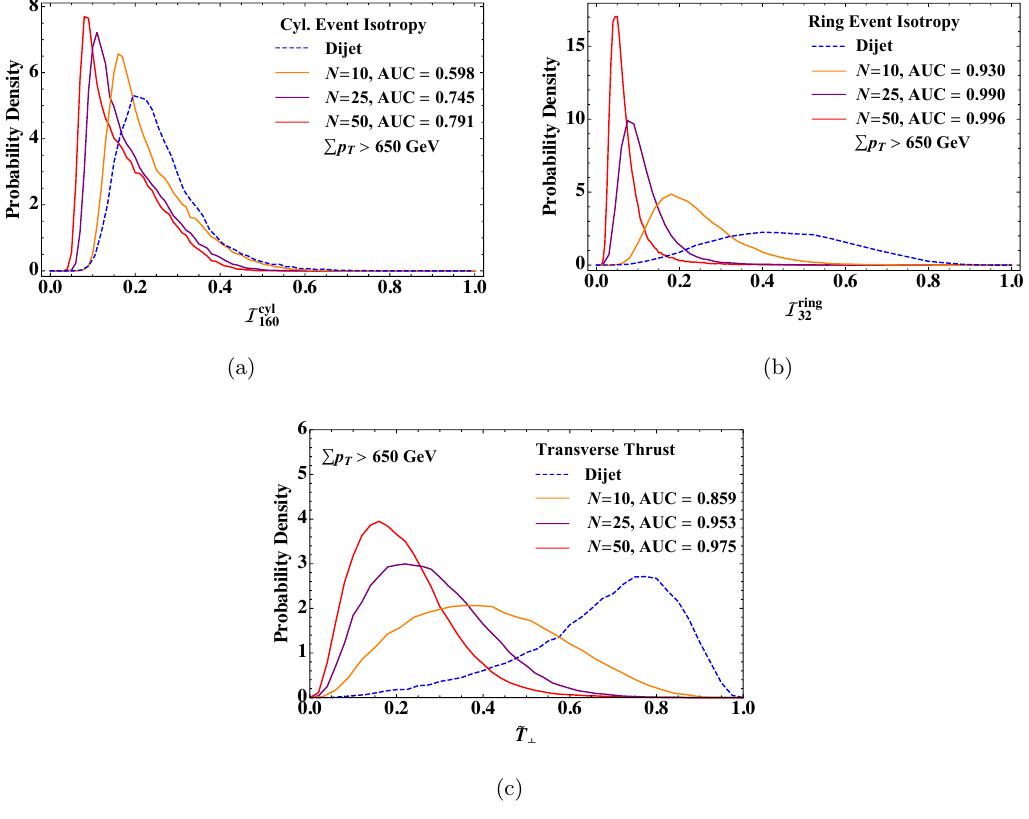
Figure 15 . Comparing the QCD dijet background to uniform N -body samples with N = f 10 ; 25 ; 50 g , using the same observables as (cid:12)gure 14 in pp collisions at values in the legend correspond to the separation power with respect to the dijet